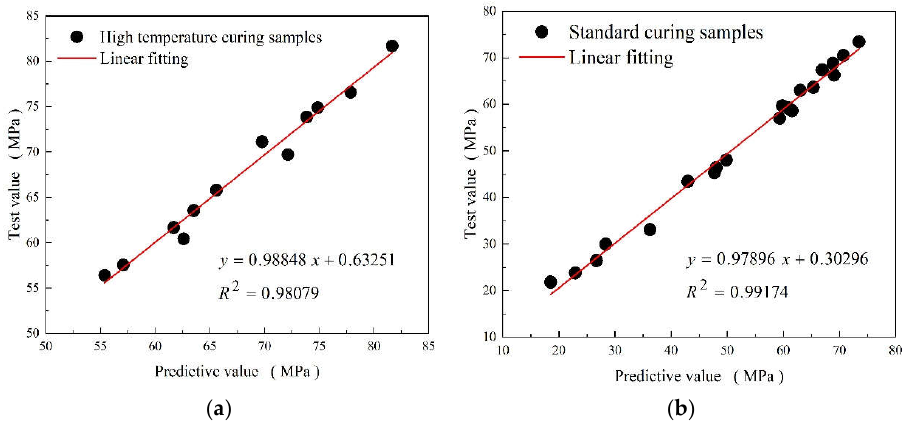
Figure 5. Relation between the Predictive value and test value of composite cementitious ( a ) under high temperature curing and ( b ) standard curing conditions.